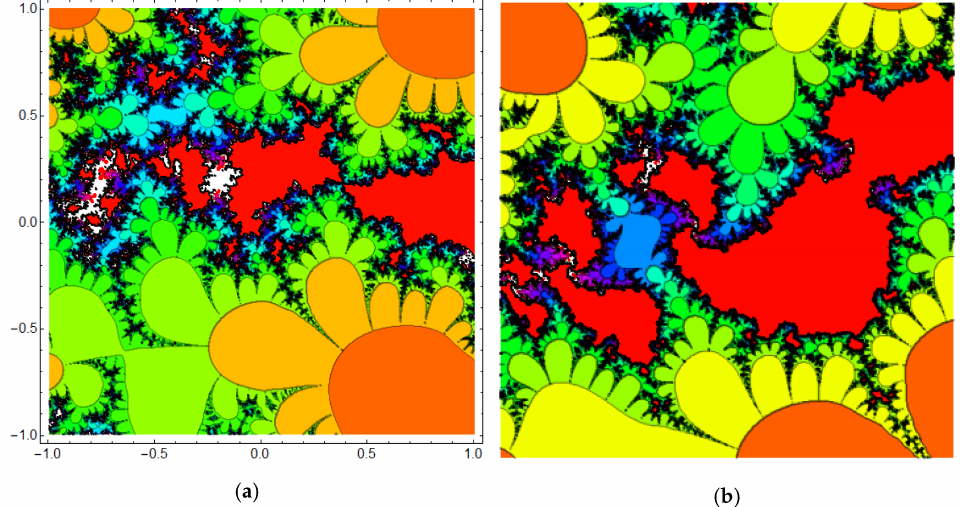
Figure 12. The effects of synchronization on the Julia sets generated by the slave fractional cosine map described in Figure 11 ( a ) before and ( b ) after attaining synchronization